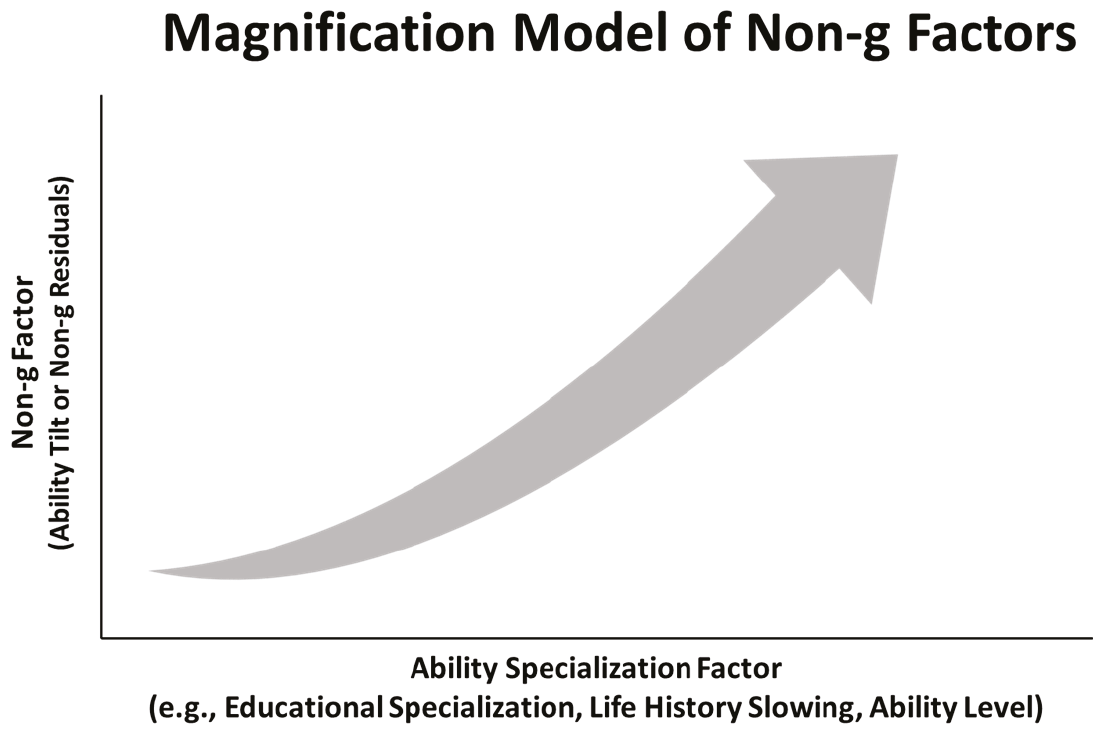
Figure 5. Magnification model of non- g factors. Non- g effects are predicted to strengthen nonlinearly with ability specialization factors (e.g., ability level, life history,